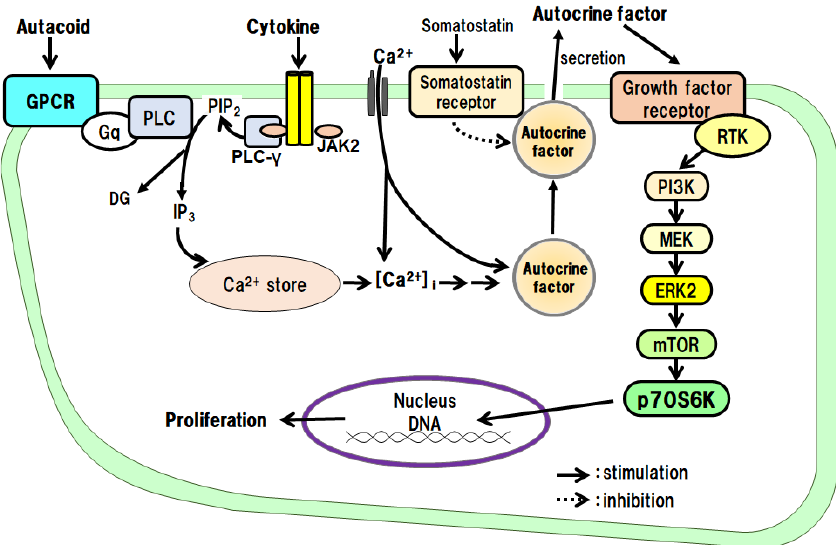
Figure 5. Hepatocyte proliferative effects of autacoids and growth hormone via an autocrine mech-